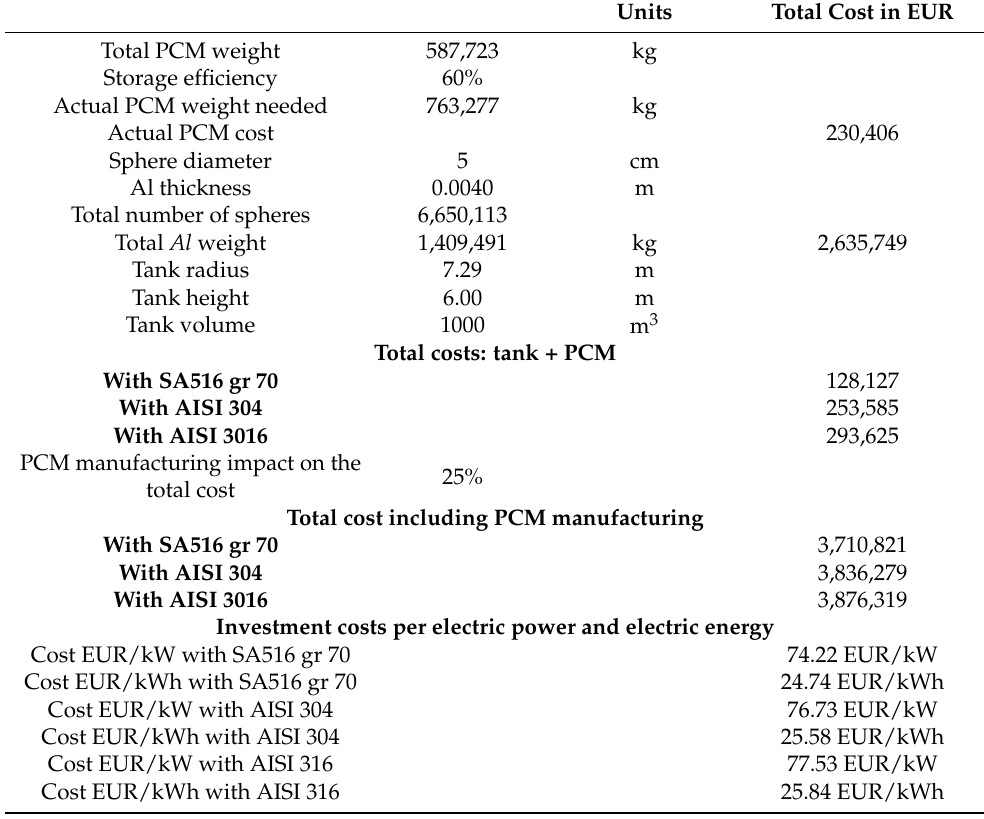
Table 8. Packed bed heat exchanger: investment cost analysis.